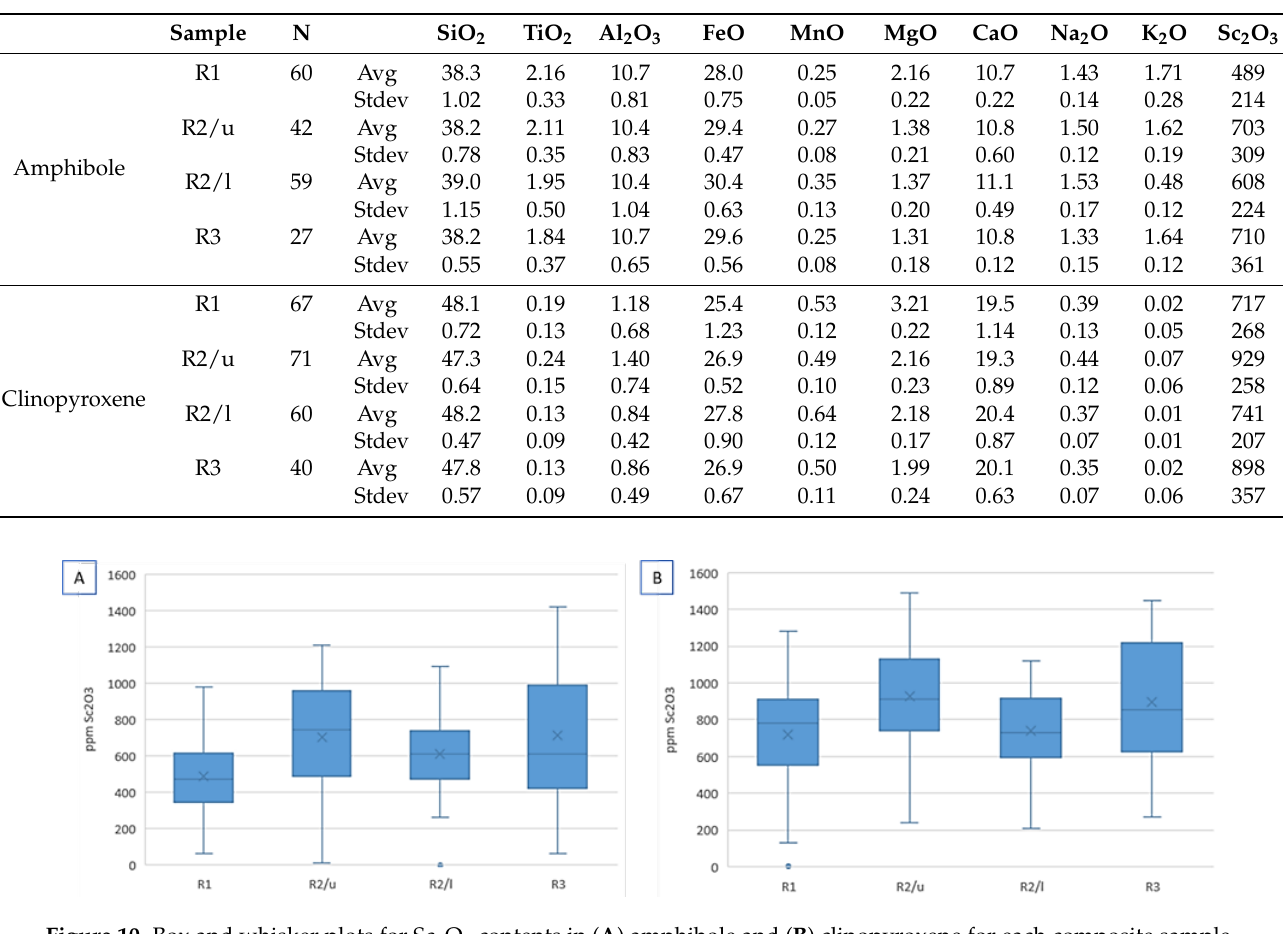
Figure 10. Box and whisker plots for Sc 2 O 3 contents in ( A ) amphibole and ( B ) clinopyroxene for each composite sample.